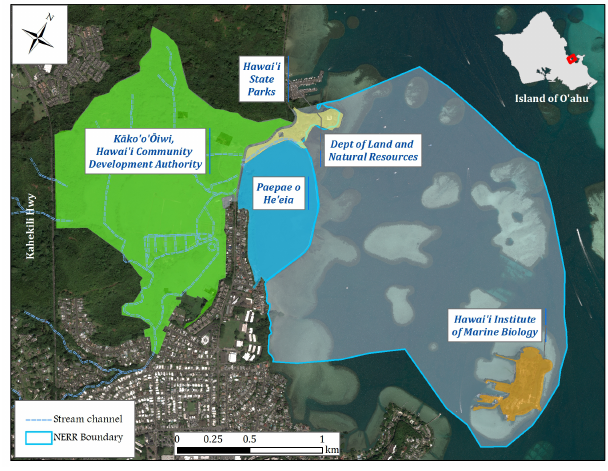
Fig. 1 . The boundaries of the He ʻ eia National Estuarine Research Reserve (NERR) in the region of Ko ʻ olaupoko on the Island of O ʻ